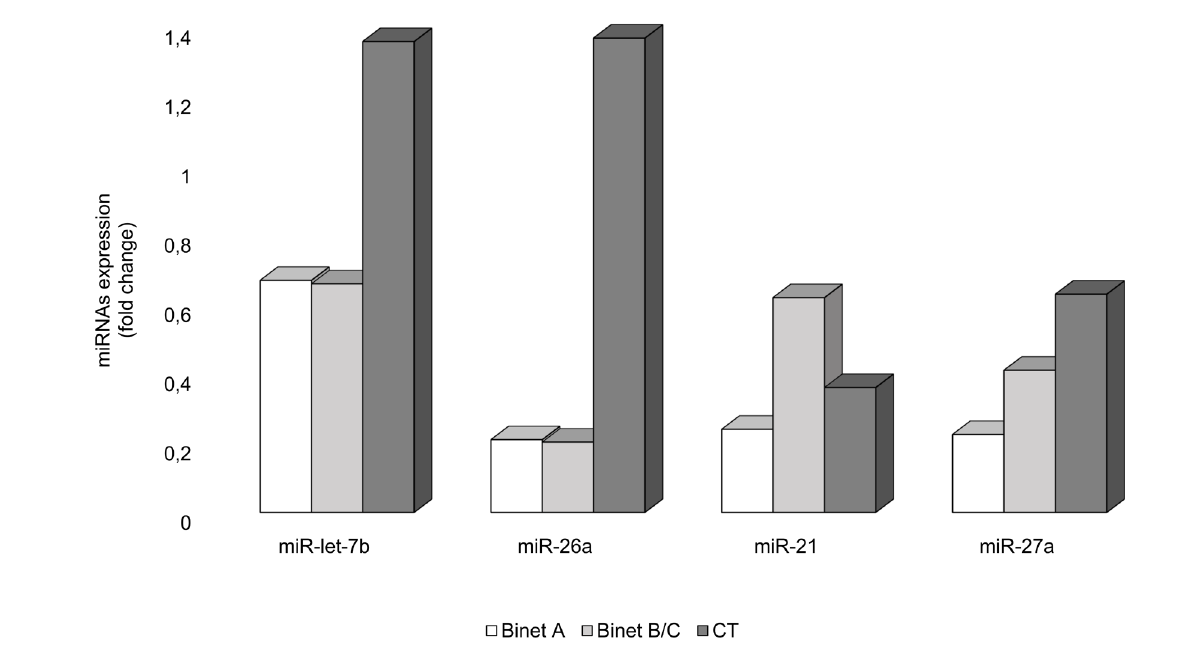
FIGURE 3 - Median values of gene expression of each miRNA according to Binet A or B+C subgroup and controls; * p -value between Binet subgroups; CT: